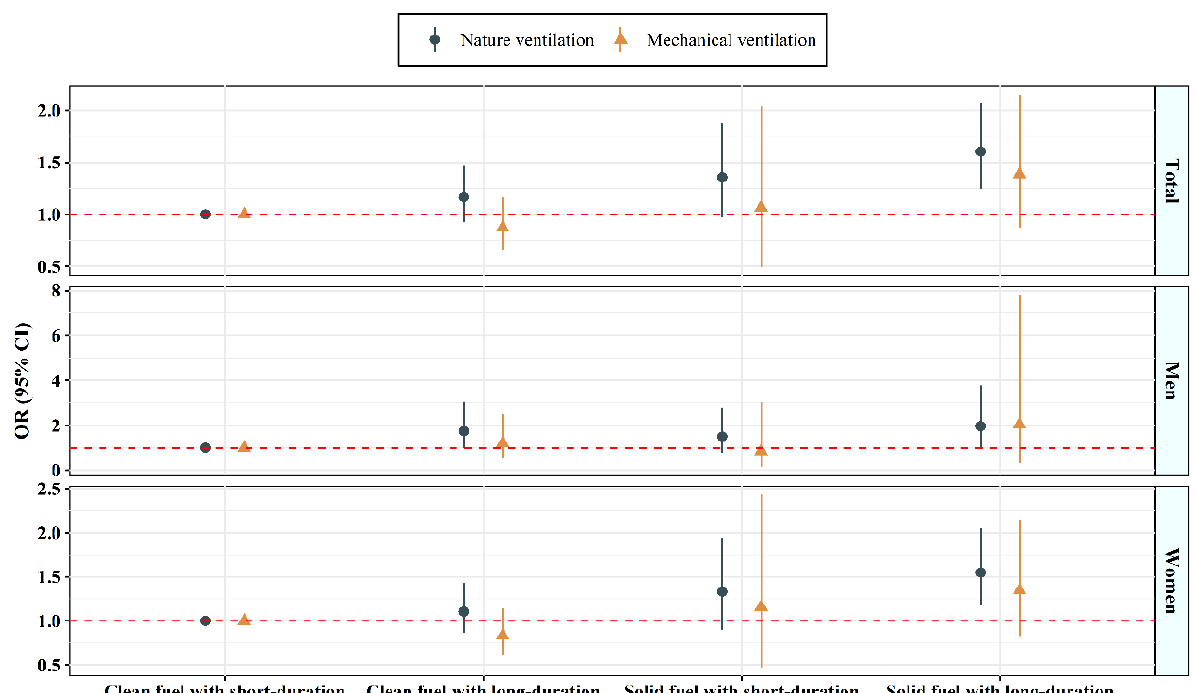
Figure 2. Combined association of fuel type and cooking duration with suicidal ideation stratified by ventilation.